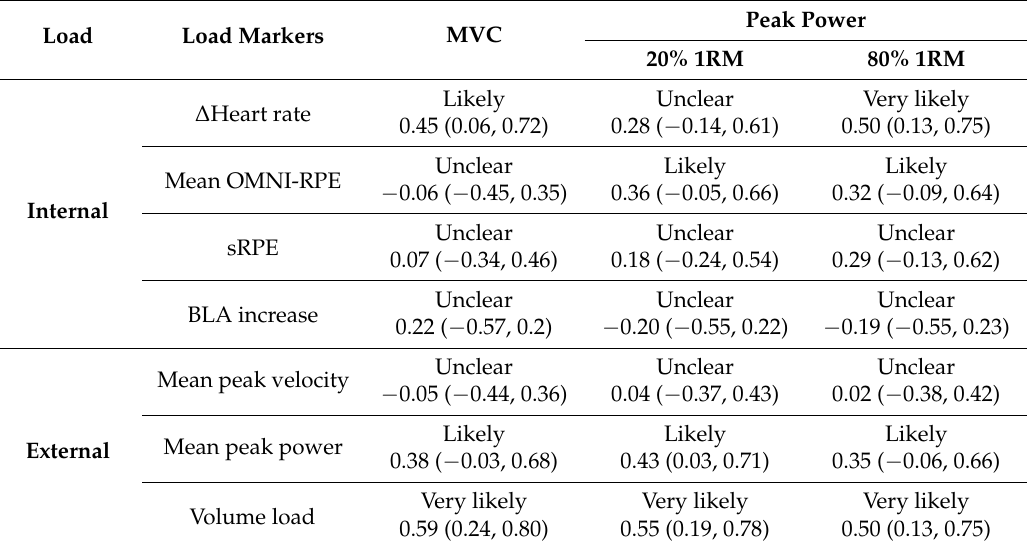
Table 4. Relationships (qualitative descriptor, upper and lower 90% confidence intervals) of internal and external load markers with